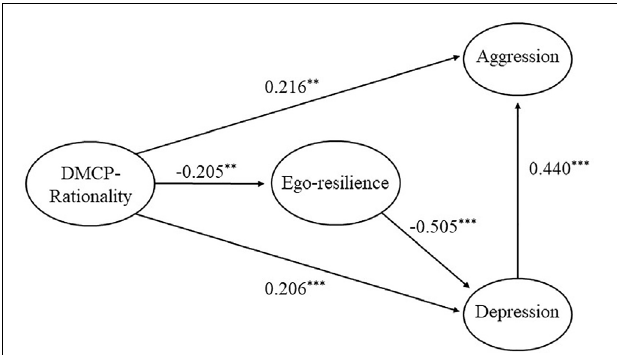
FIGURE 2 | The final model’s path. All estimates are standardized coefficients. ** p < 0.01, *** p <